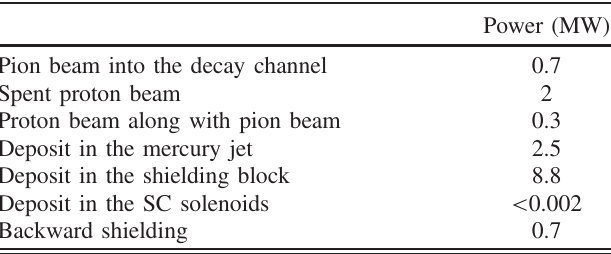
TABLE II. Power distribution at the target